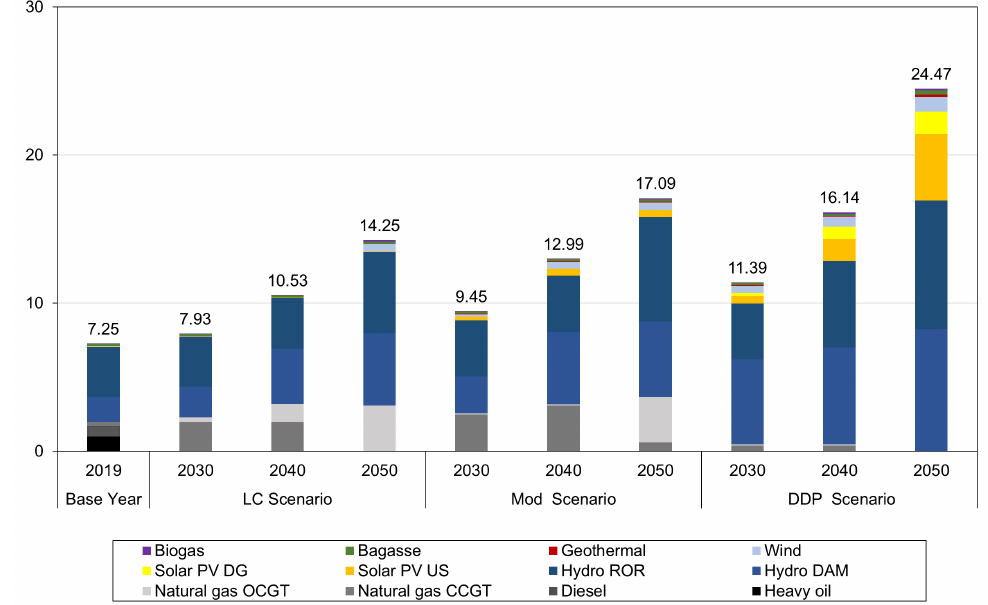
Figure 9. Installed capacity in GW for the Ecuadorian power sector by 2019, 2030, 2040, and 2050 per